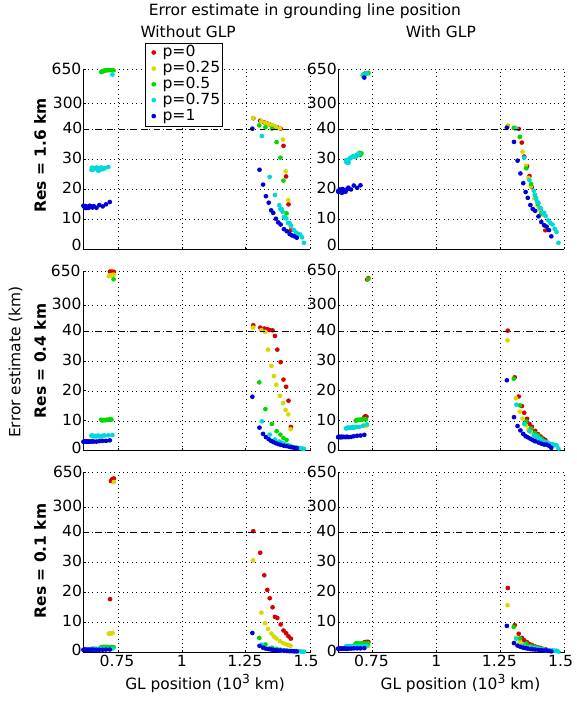
Figure 10. As in Fig. 6, but showing only the retreat experiment over the polynomial bed and with benchmark grounding-line po- sition instead of A along the x -axis. The dashed line (at 40km) in each panel shows the location of a transition in scale of the y - axis used to show large errors without losing the differences be- tween smaller errors. The error in grounding-line position is consis- tently lower at a given grounding-line position when p = 1 than for smaller values of p . The figure shows that errors tend to increase as the grounding line approaches the unstable region (empty gap in each